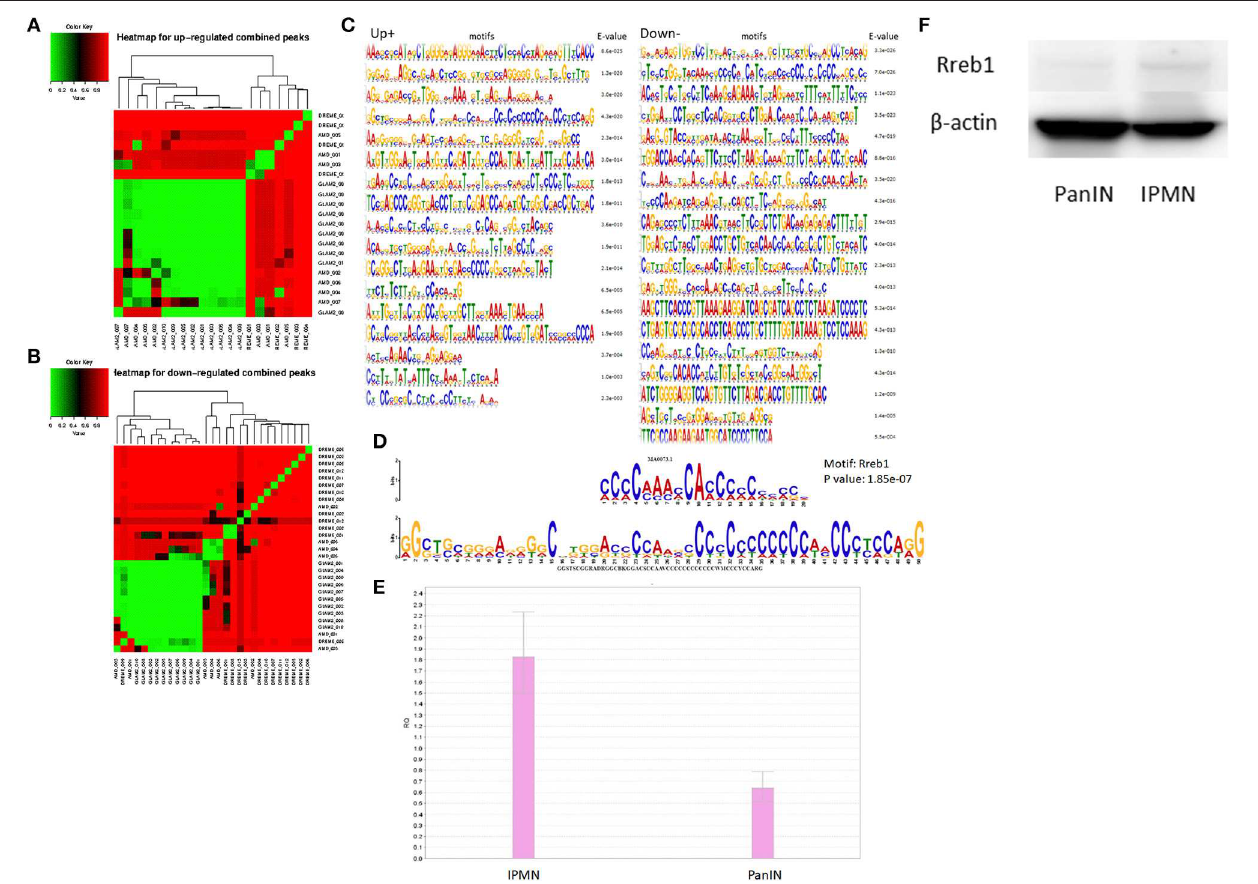
FIGURE 4 | Clusters screened by the differentially expressed criteria and divided into up-regulated or down-regulated peaks were used for motif discovery analysis, heat maps represented results shown as up-regulated and down-regulated in (A,B) . (C) Motifs significantly detected at the promoter region of target genes (enrichment score < 0.05). (D) Comparison analysis with standard motifs representations in the JASPAR core database using TOMTOM. The sequence logos at the top showed the transcription factor MA0073.1 (Rreb1), and the ones below the binding match motif. (E) qRT-PCR result suggested Rreb1 expression in pancreatic intraepithelial neoplasia/intraductal papillary mucinous neoplasm (PanIN/IPMN) correlated with findings from motif search. (F) Rreb1 protein (245 kDa) expression level of IPMN/PanIN cell lines; beta-actin was used as the internal